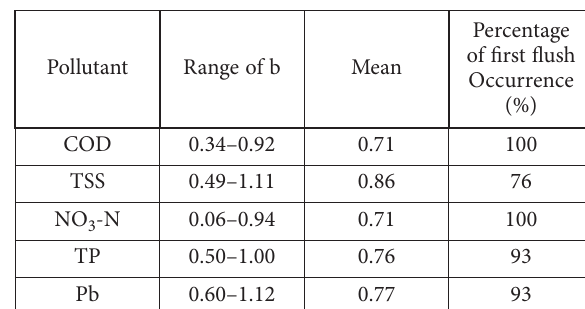
Table 2. The first flush coefficient values for different pollutants